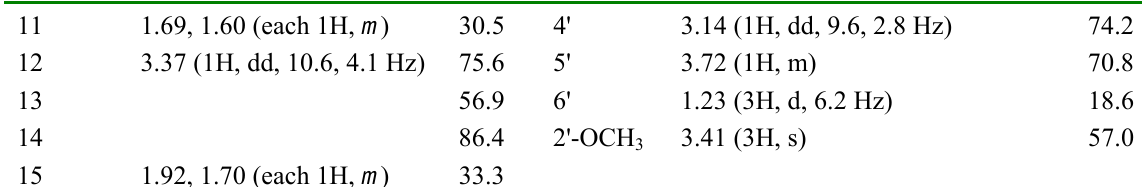
values, µ g·mL -1 ).